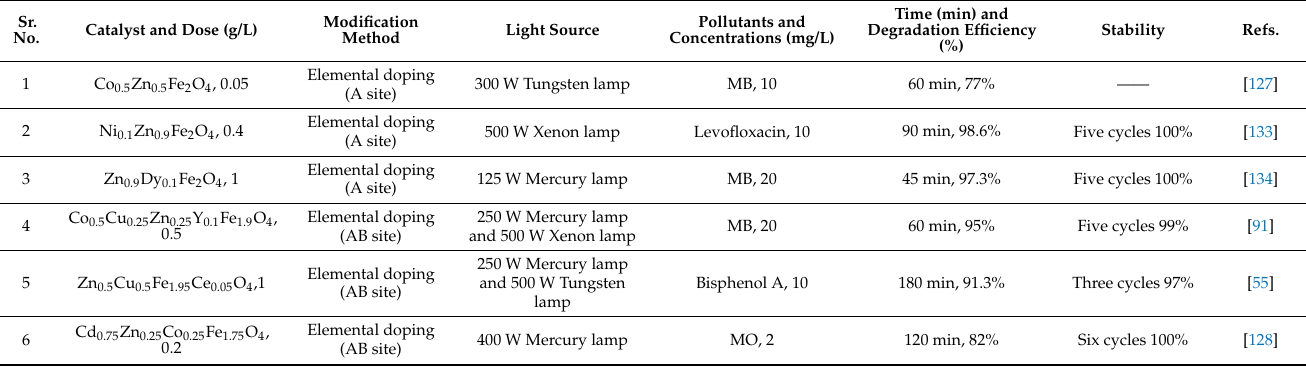
Table 4. The degradation performance of the ZnFe 2 O 4 photocatalyst contaminants using different modification